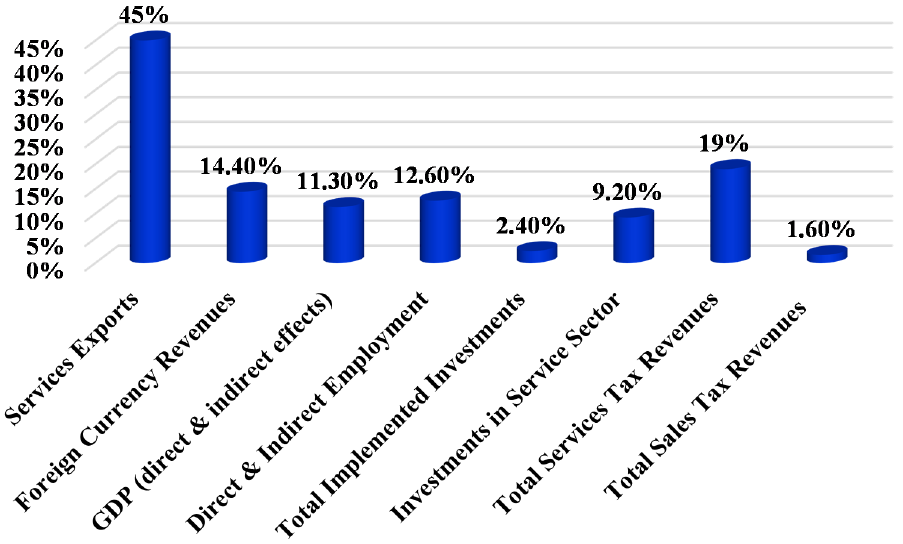
Figure 1. Tourism importance in Egypt during 2012.